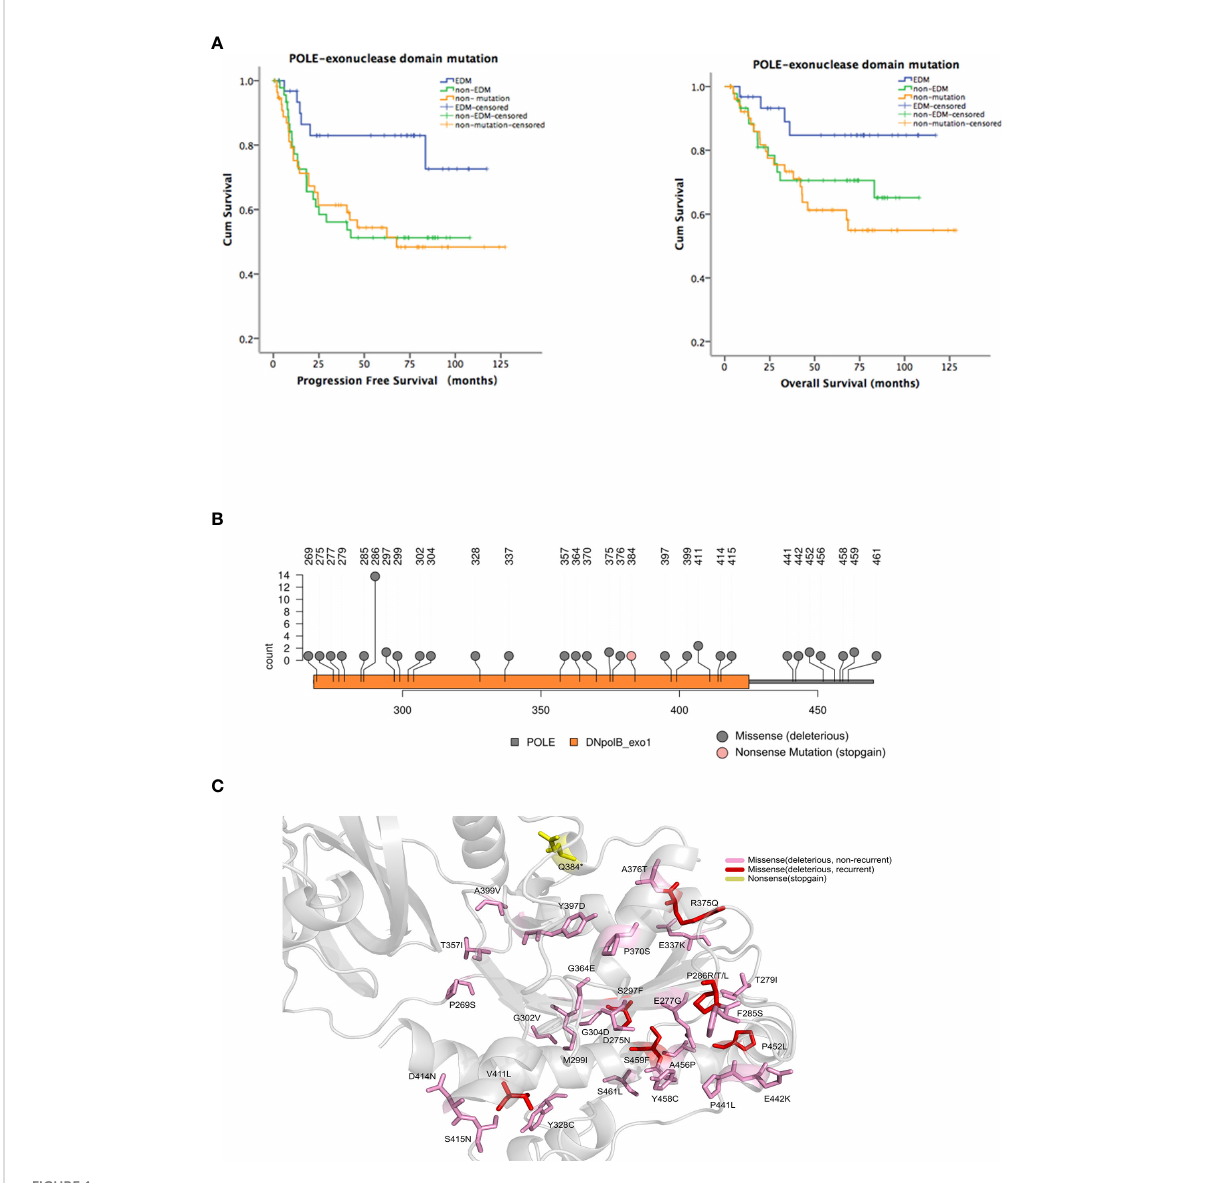
FIGURE 1 Identi fi cation of hotspot exonuclease domain mutations (EDMs) in the DNA polymerase ϵ gene ( POLE ) in endometrial cancer. A total of 35 nonsense/stop-gain, 39 frameshift, and 57 missense mutations were identi fi ed in 69/138 (50%) endometrial tumor samples from patients. Among these mutations, there were 49 POLE EDMs, comprising 1 nonsense/stop-gain mutation and 48 missense mutations, in 32/138 (23.2%) samples. (A) Patients were divided into EDM (n = 32), non-EDM (n = 37), and non-mutation (n = 69) groups. Kaplan-Meier analysis was performed to evaluate the association of POLE EDMs with progression free survival (PFS) and overall survival (OS). Blue line: patients with POLE EDM tumors; green line: patients with non-EDM tumors; orange line: patients with non-mutation tumors. (B) Prediction of deleterious EDMs. Pink dot: stop mutations; gray dot: deleterious mutations. (C) Modelling of the exonuclease domain mutations in POLE. Gray, 9 – 14 exons, 268 – 471 residues; pink, unrepeated deleterious mutations; red, recurrent deleterious mutations; yellow, stop